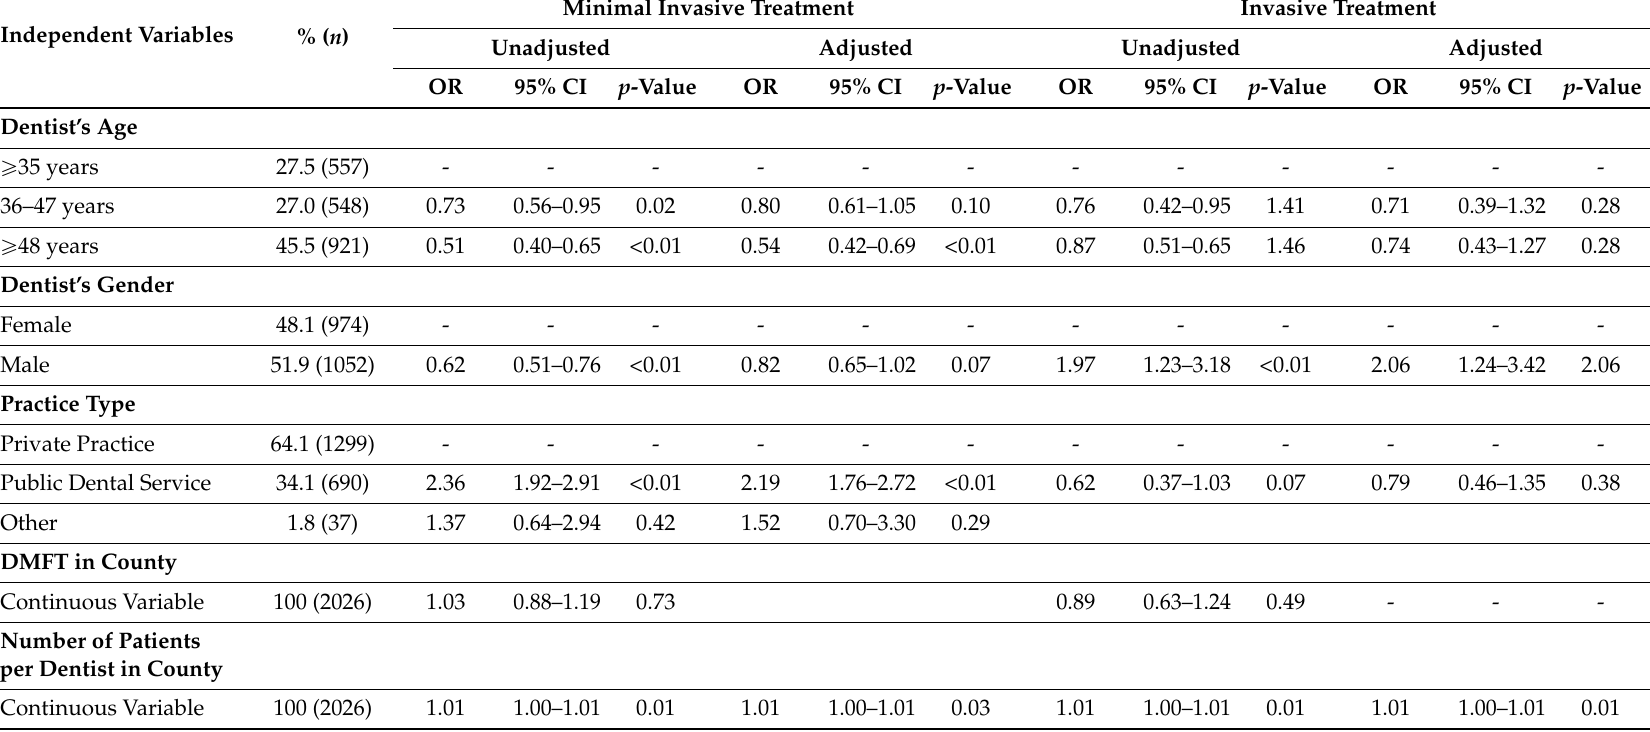
Table 5. Variables related to the dentists choice of a minimally invasive and invasive treatment approach in Patient Case